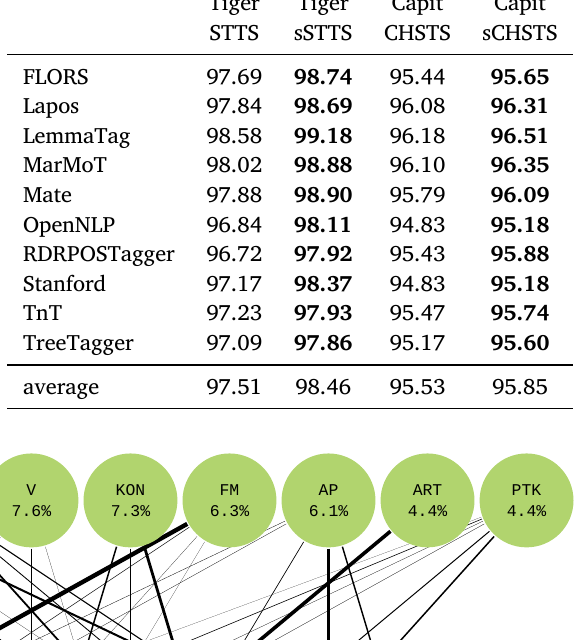
POS accuracy for all tagsets on Tiger and Capitularies in %